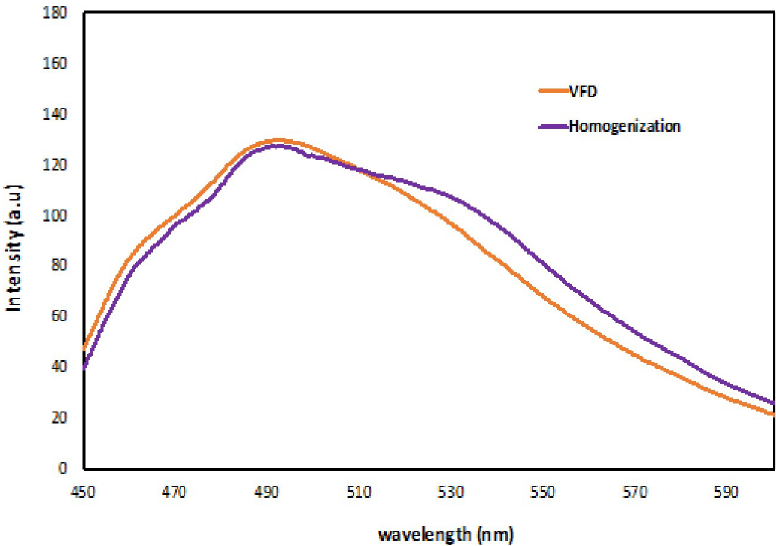
Fig 6. Fluorescent spectrums (path-length of quartz cuvette: 10mm; excitation band slits: 10 nm; emission band slits: 10 nm; scan rate: 1800 nm/min; excitation wavelength: 425 nm; emission spectra: 450–600 nm) for VFD and homogenization